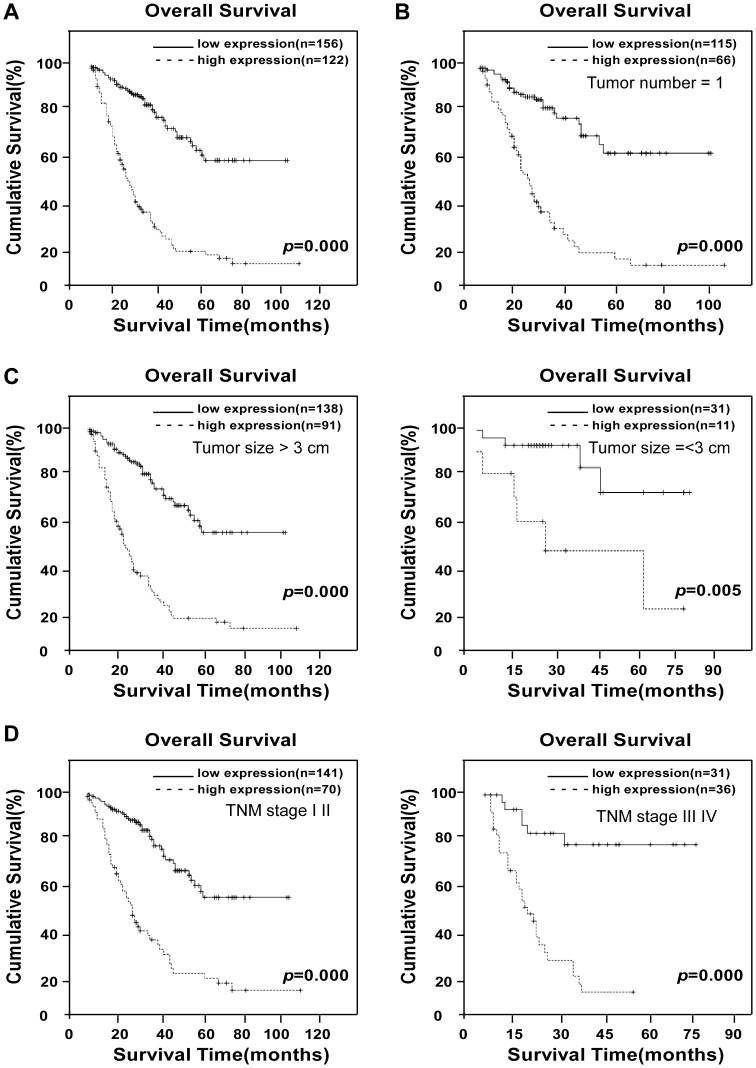
Kaplan-Meier analysis of OS in 278 cases based on URGCP/URG4 expressions in HCC clinical subgroup.Kaplan–Meier curves with univariate analyses (log-rank) for patients with low- versus high-URGCP/URG4 expression (A). OS in patients with a single tumor lesion (B). When patients were divided into subclinical groups according to tumor size, probabilities of survival with either HCC lesion diameter >3 cm (left) or ≤3 cm (right), high- and low-URGCP/URG4 expression was found to distinguish lower and higher SO rates, respectively (C). OS rates in patients subgrouped into TNM stage I-II (left) and TNM stage III-IV (right) as differentiated by high- or low-URGCP/URG4 expression (D).